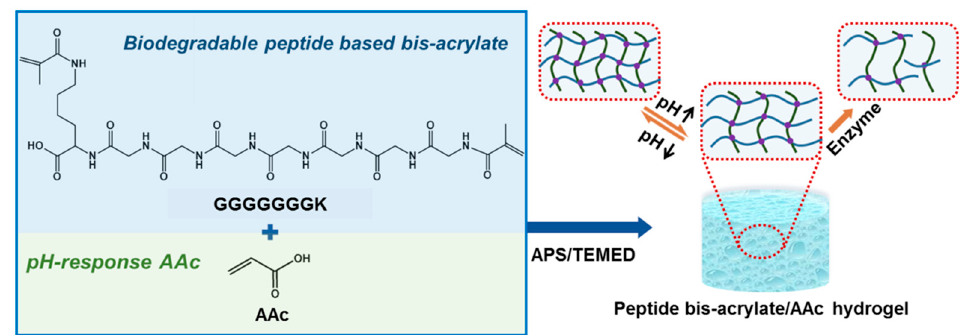
Figure 1. Schematic diagram of the peptide-based bis-acrylate/ acrylic acid (AAc) hydrogel with pH sensitivity and biodegradability. The hydrogel was formed by radical polymerization using ammonium persulfate (APS) as an initiator and tetramethylethylenediamine (TEMED) as an accelerator.